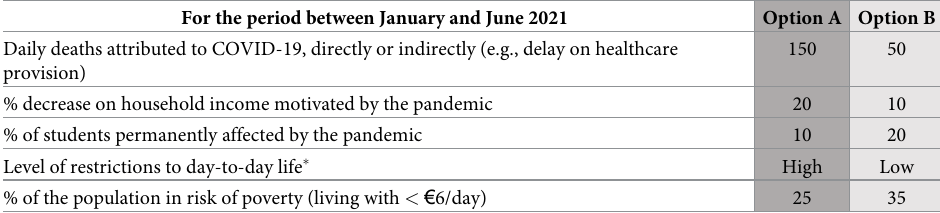
Table 2. Example of a choice set. For the period between January and June 2021 Option A Option B Daily deaths attributed to COVID-19, directly or indirectly (e.g., delay on healthcare provision) % decrease on household income motivated by the pandemic % of students permanently affected by the pandemic Level of restrictions to day-to-day life � High Low % of the population in risk of poverty (living with < € 6/day) � Low: Large-events restrictions and no bars/clubs; Medium: Night curfew and maximum 5 people gatherings; High: Full